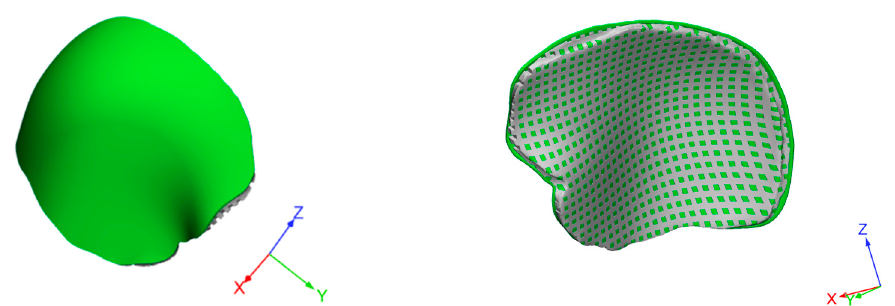
Figure 5. Three-dimensional geometrical models of a customized hybrid device for large cranial defect: top view evidencing the external cement layer ( left ); bottom view highlighting the cement infiltration in the fully interconnected pore network ( right ). Green color was chosen to identify the cement component of the hybrid device.